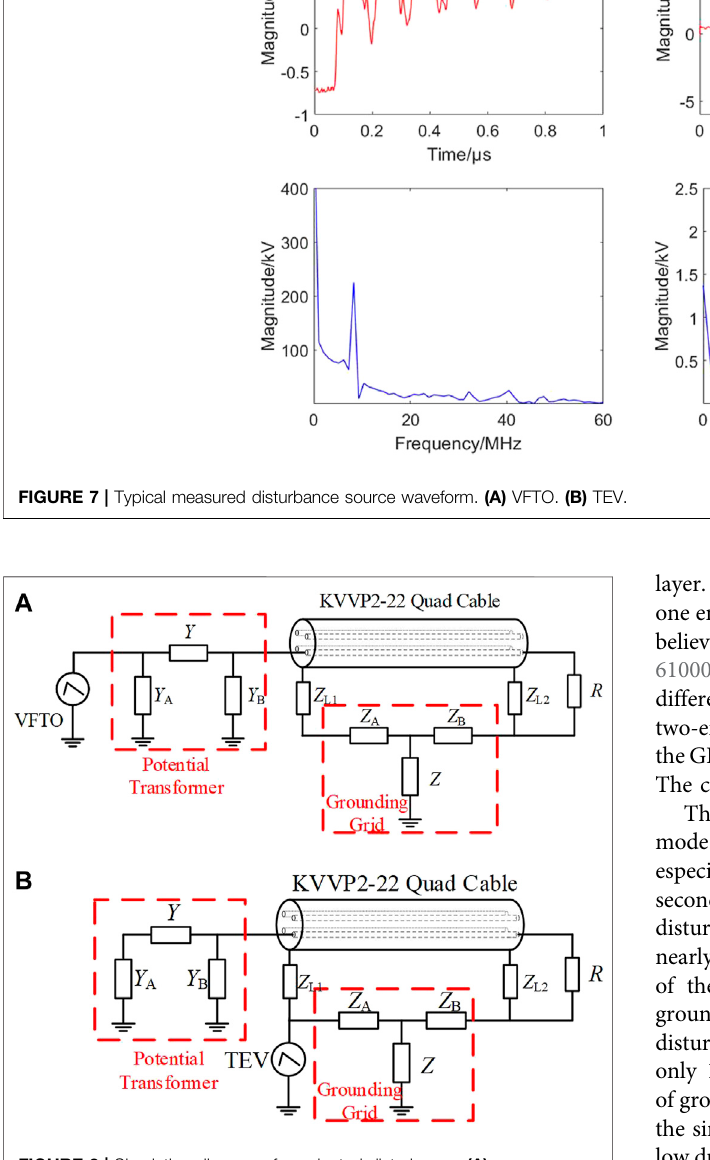
FIGURE 8 | Simulation diagram of conducted disturbance. (A) Calculation model of capacitive conducted disturbance voltage. (B) Calculation model of resistive conducted disturbance